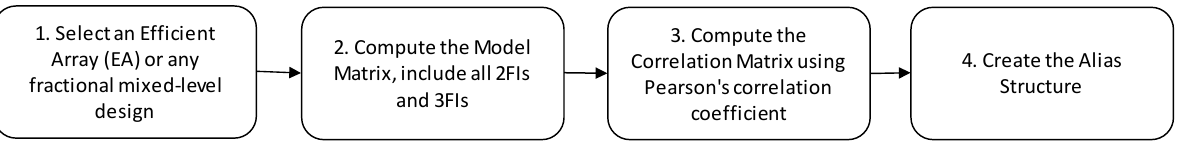
Figure 3. Method for constructing alias structures for mixed-level designs.